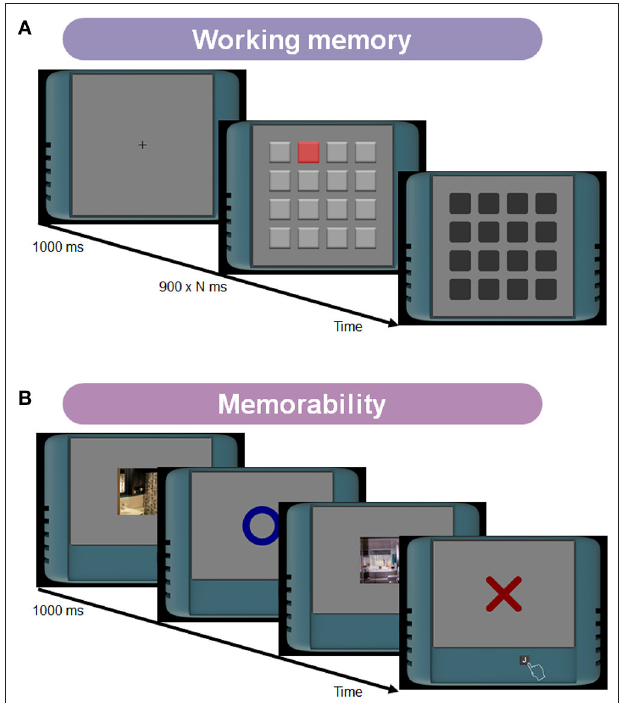
FIGURE 4 | (A) Stimuli and tasks in the working memory task. On each trial, one of sixteen squares was sequentially flashed with a reddish color briefly. After the presentation, participants answered the sequence by clicking on the squares in the same order. (B) Stimuli and tasks in the memorability task. On each trial, a natural scene photograph was presented one by one. Participants were asked to remember each photograph and answer whether the photograph is presented twice or